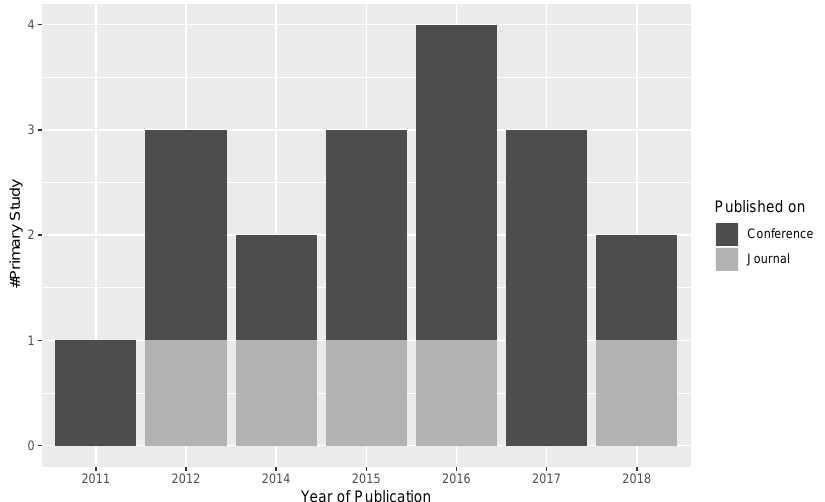
Figure 3. Distribution over the years of selected studies per paper type (journal and conference). (Authors’ own).